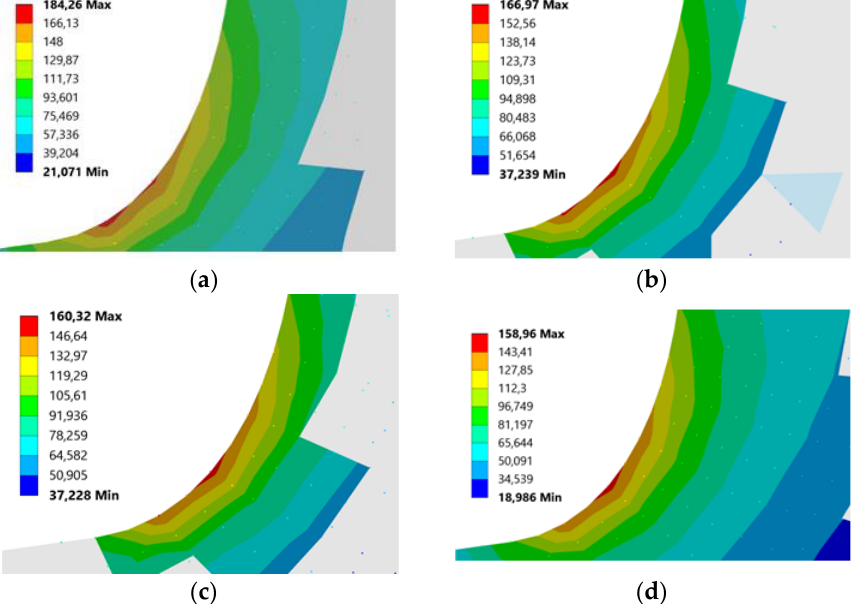
Figure 7. Root stress results for hybrid gears generated rack tip radius, ρ 1 = 0.1 xm for different RTes;